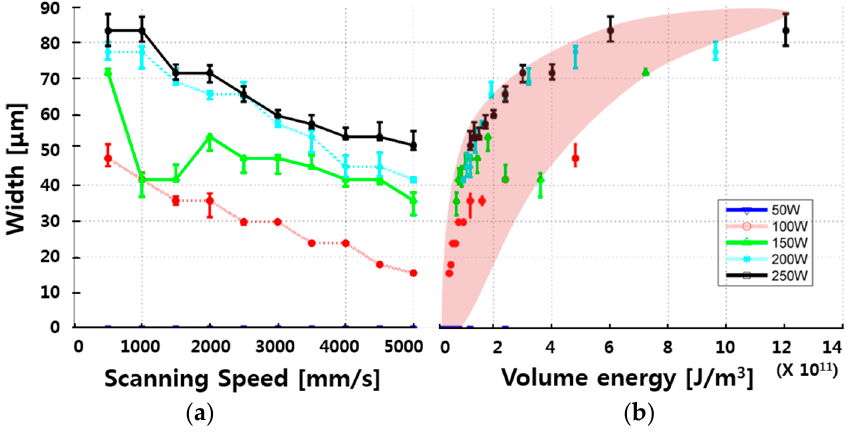
Figure 4. ( a ) Melting width VS. Scanning speed; ( b ) Volume energy.